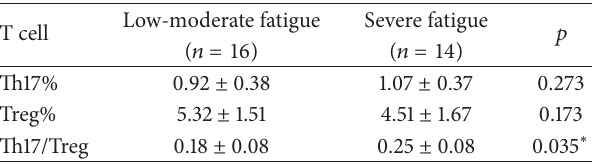
Table 3: The percentages and ratio of Th17 and Treg cell in PSF patients.